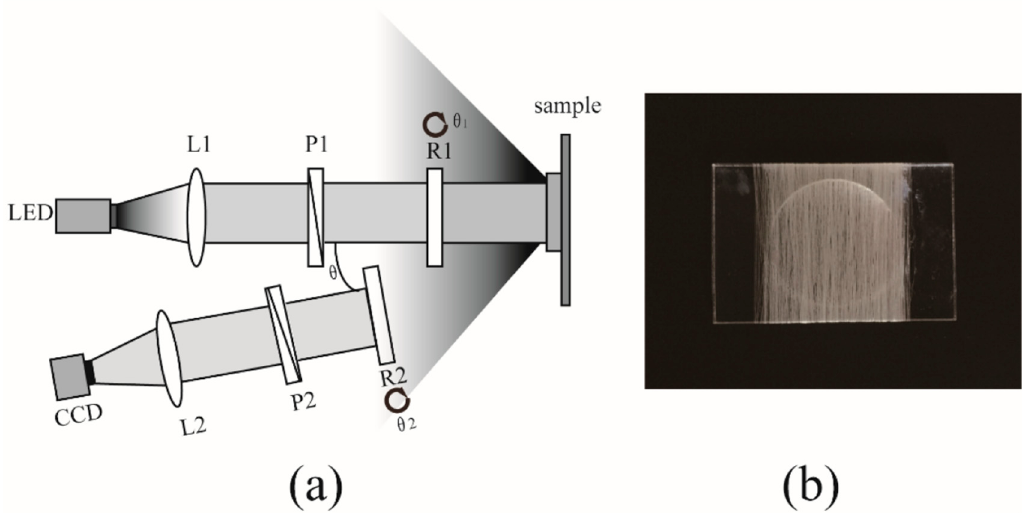
Figure 10. ( a ) Schematic of experimental setup for the backscattering Mueller matrix measurement. P1, P2: polarizer; R1, R2: quarter-wave plate; L1, L2: lens. The oblique incident angle θ is about